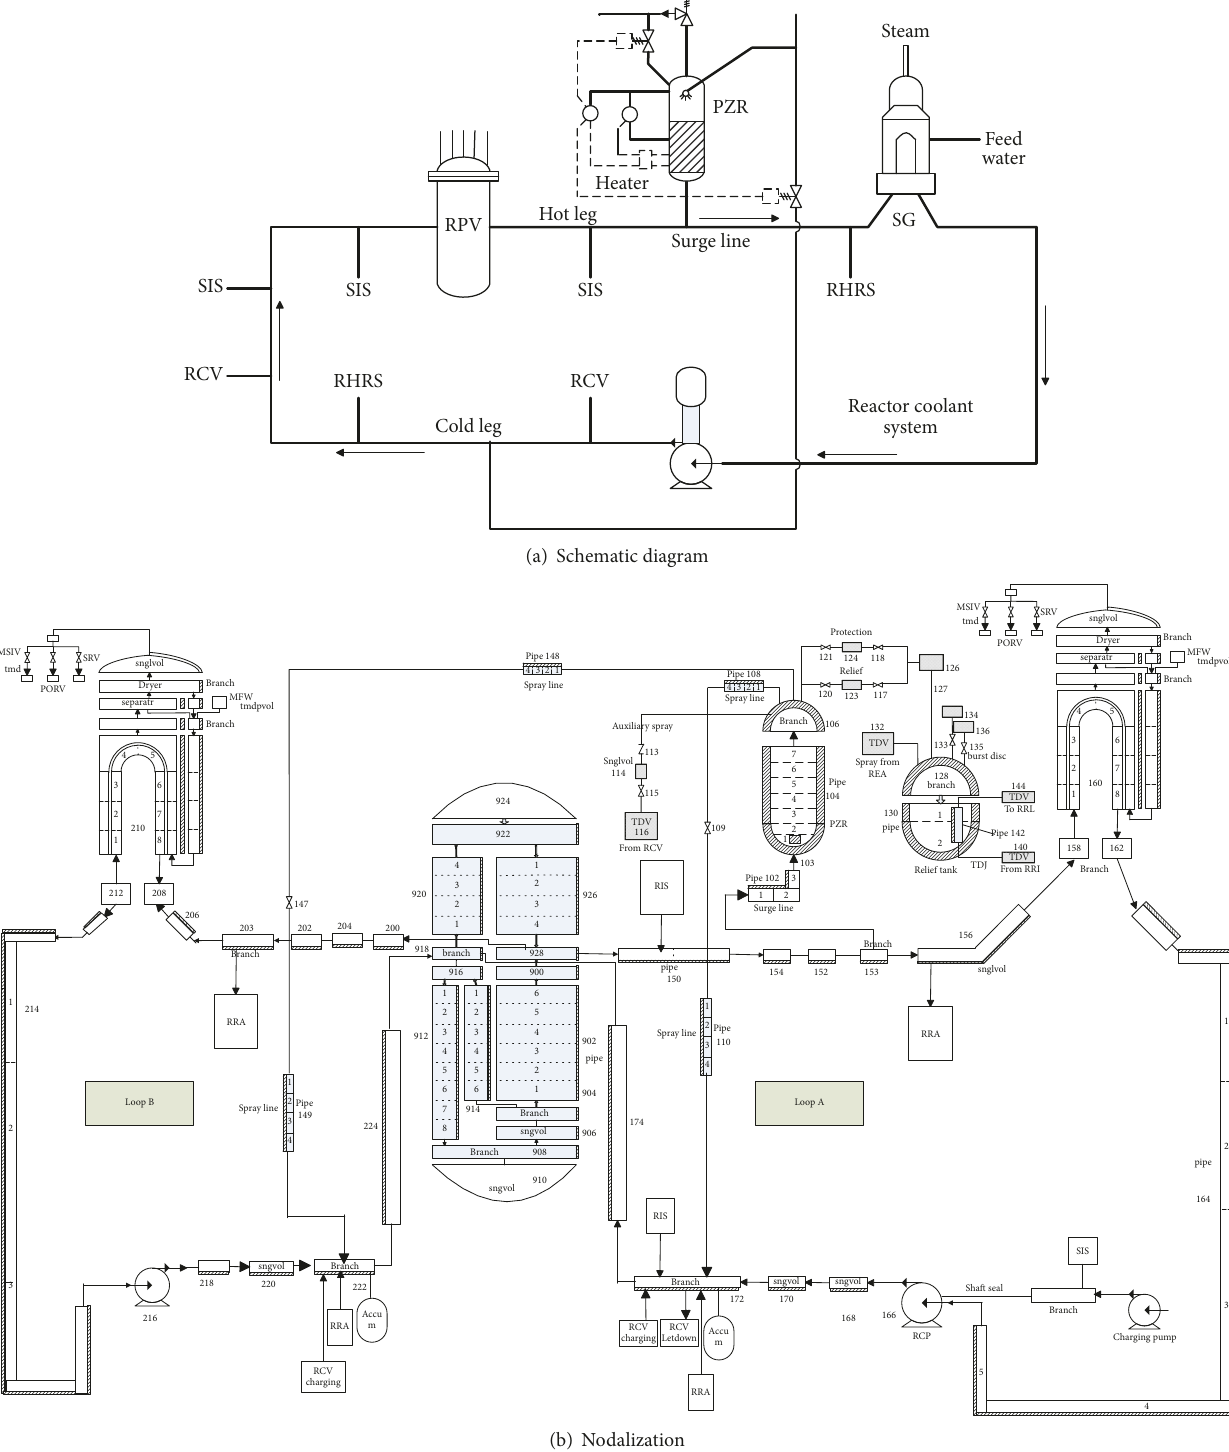
Figure 2: The Chashma NPP RCS and RELAP5 nodalization